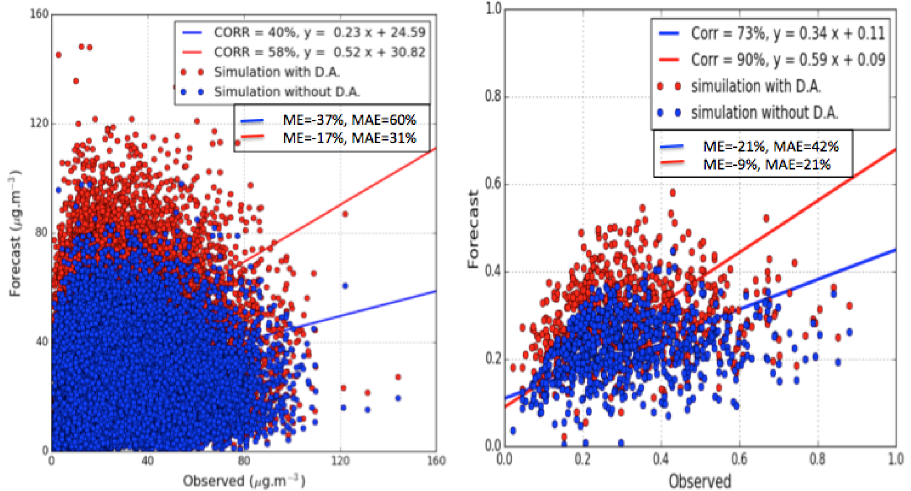
Figure 6. Scatter plots of the match-ups of model outputs surface PM 2.5 concentrations with AirBase observations ( right panel ) and AOD values with AERONET AOD ( right panel ). CORR, ME and MAE refer to the correlation coefficient, Mean Error and Mean Absolute Error, respectively.